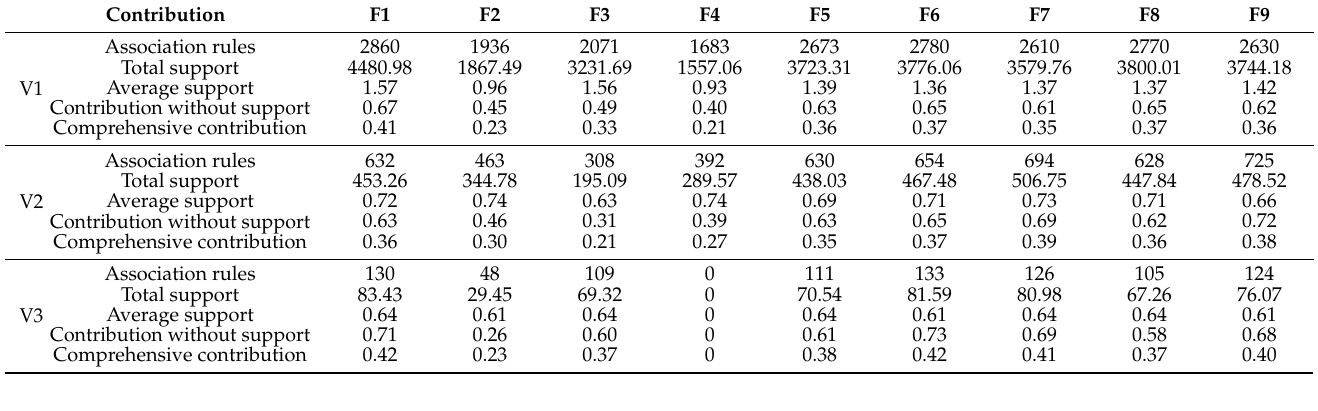
Table 5. Statistical results of the data mining and association rules.